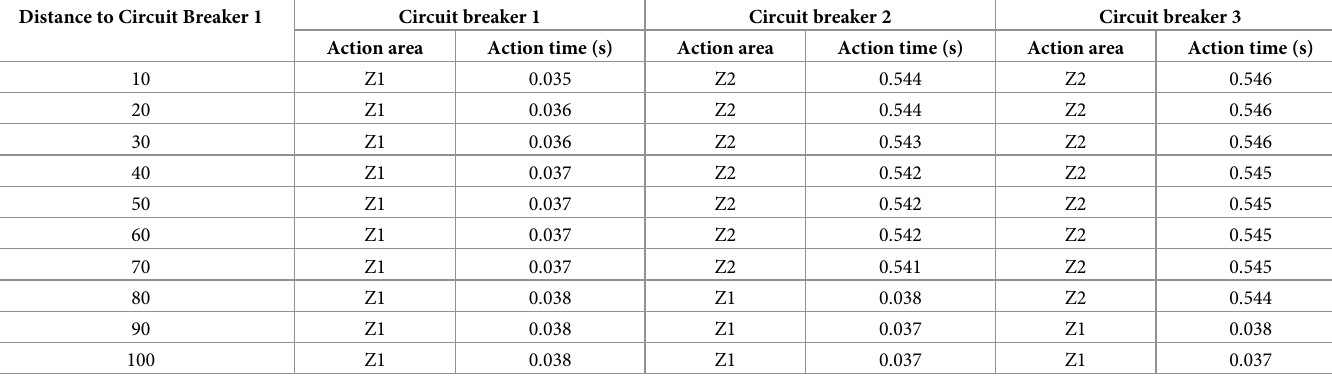
Table 3. Protection operation time of each side of the T connection line in the protection